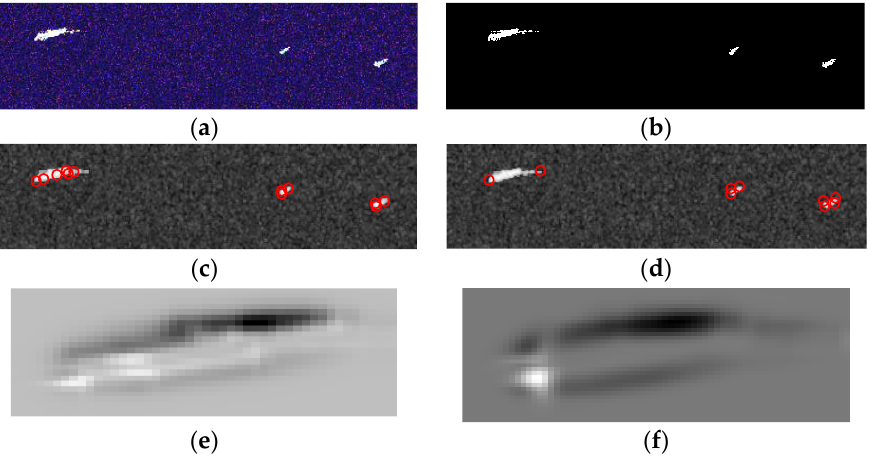
Figure 3. Synthetic data and keypoint detection results: ( a ) Pauli pseudo-color image; ( b ) ground truth image; ( c ) keypoint detection result of PolSAR-SIFT keypoint detector shown in the log SPAN image, and the red circle indicates the location of the keypoint; ( d ) keypoint detection result of SAR-SIFT keypoint detector shown in the log SPAN image, and the red circle indicates the location of the keypoint; ( e ) PolSAR-Harris response function image of the large ship; and ( f ) SAR-Harris response function image of the large ship.